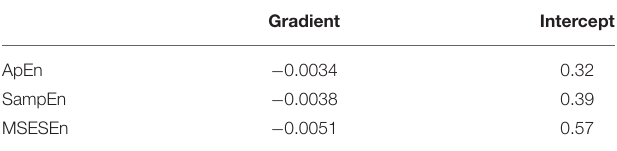
TABLE 3 | Gradients and intercepts for different indicators in Figure 8 . Gradient Intercept